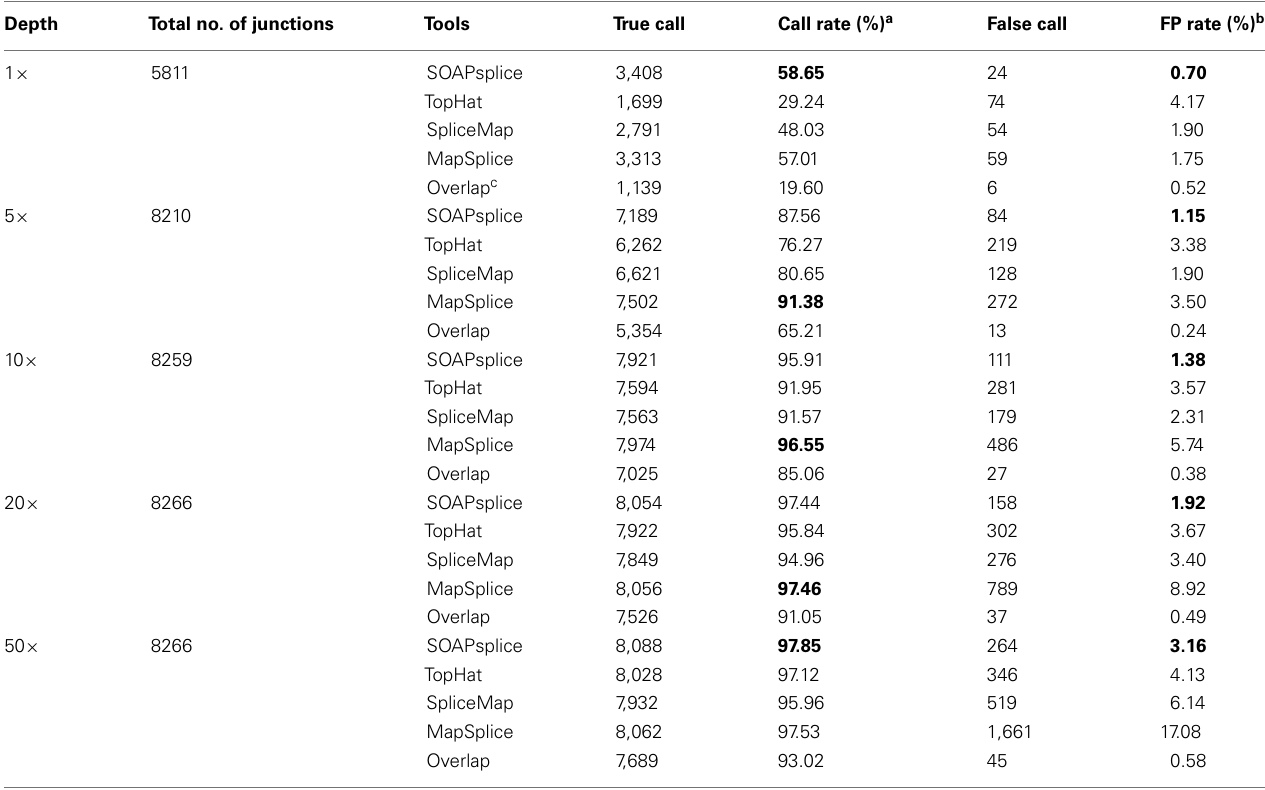
TableA1 | Statistics of the junctions detected on the 50-bp simulated reads.